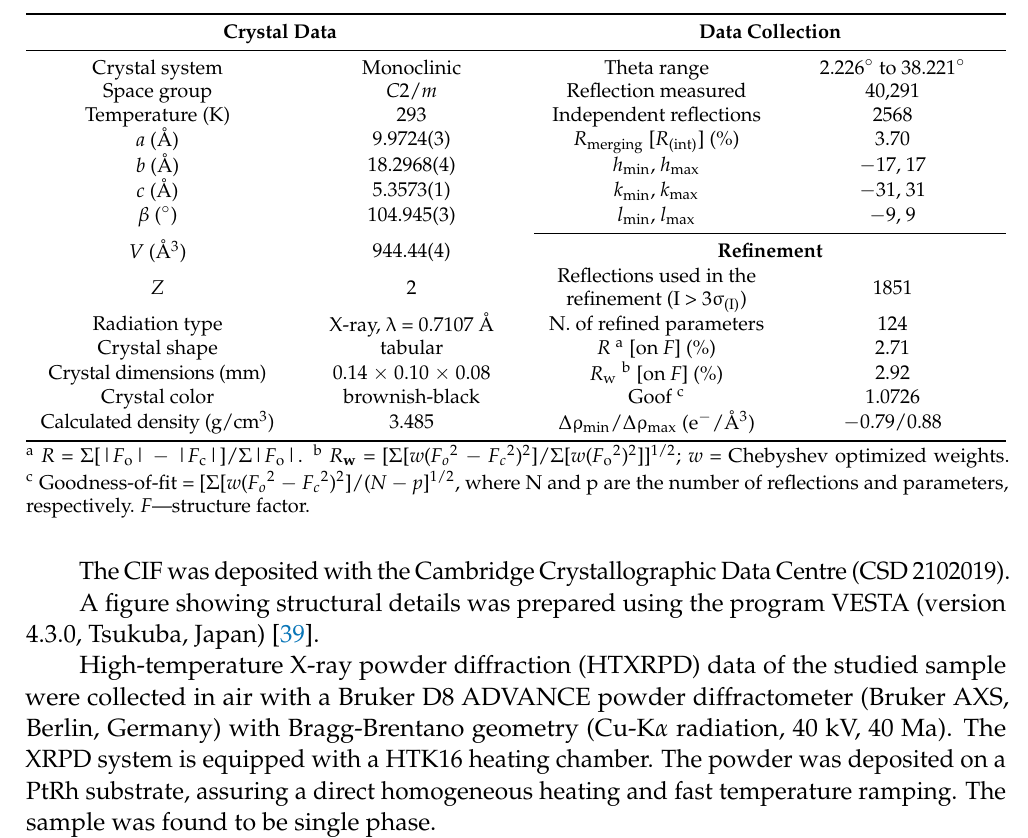
Table 2. Selected data on single crystal, data collection, and structure refinement parameters of the studied potassic-hastingsite